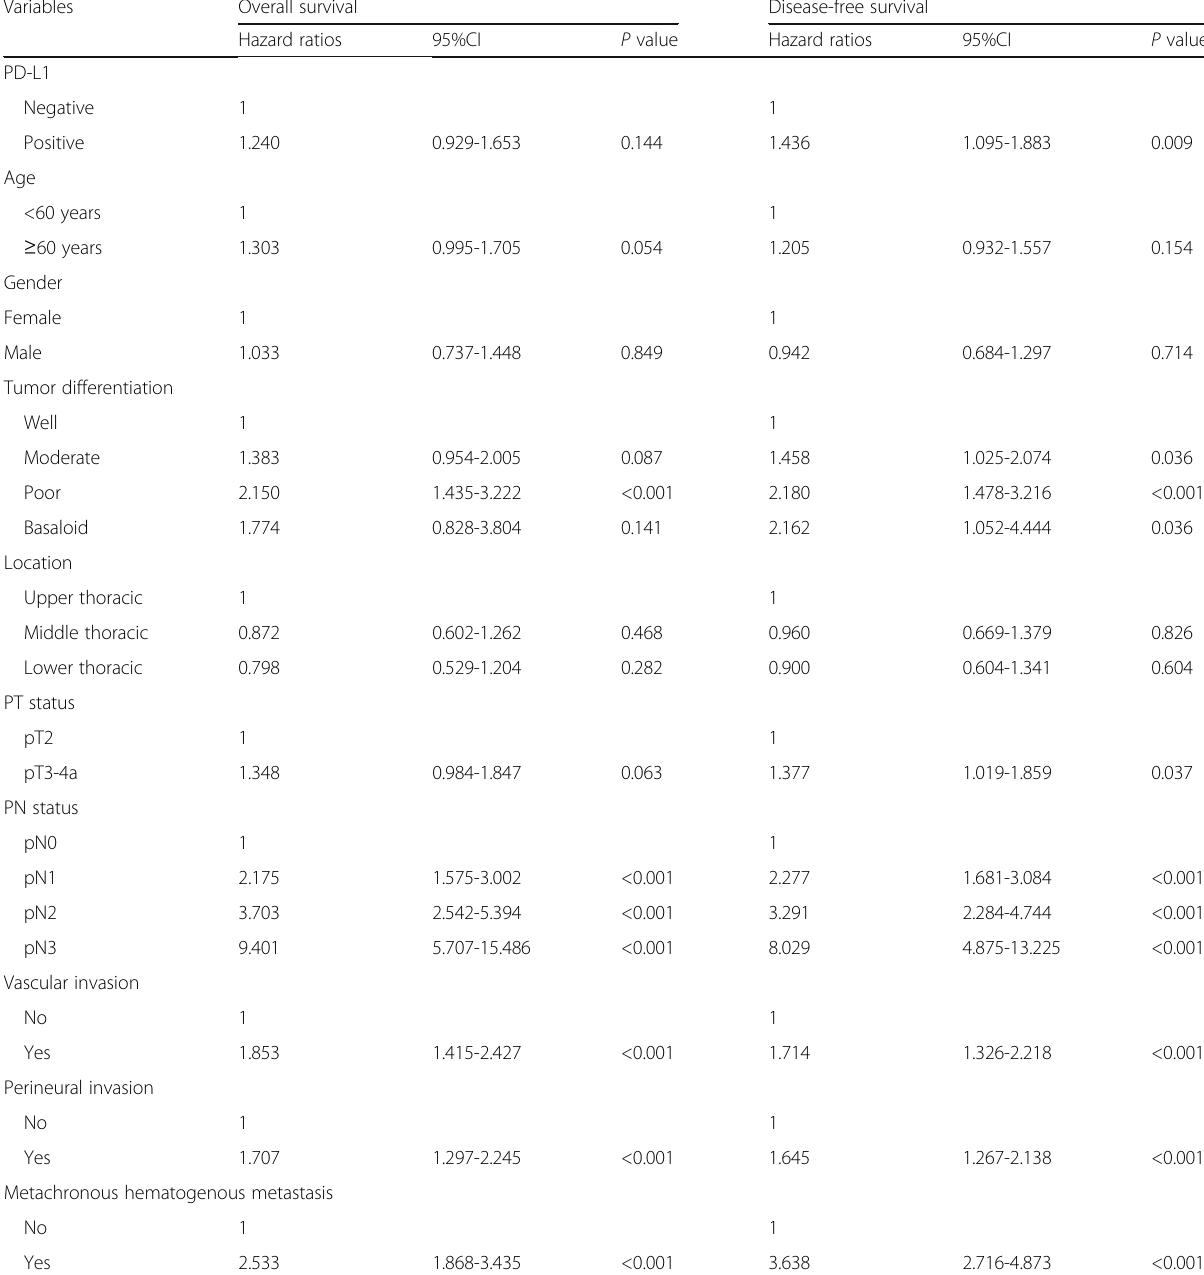
Table 5 Univariate COX analysis to determine factors associated with patient survival for PD-L1 expression in tumor cells